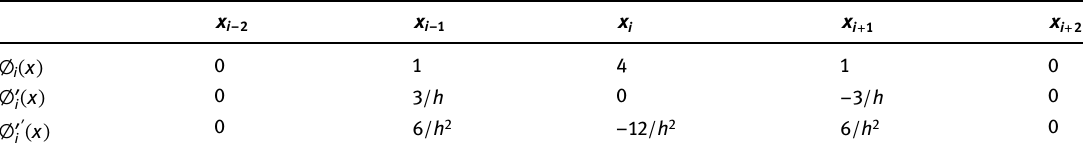
Table 1: Values of x ∅ i ( ) and its derivatives at the